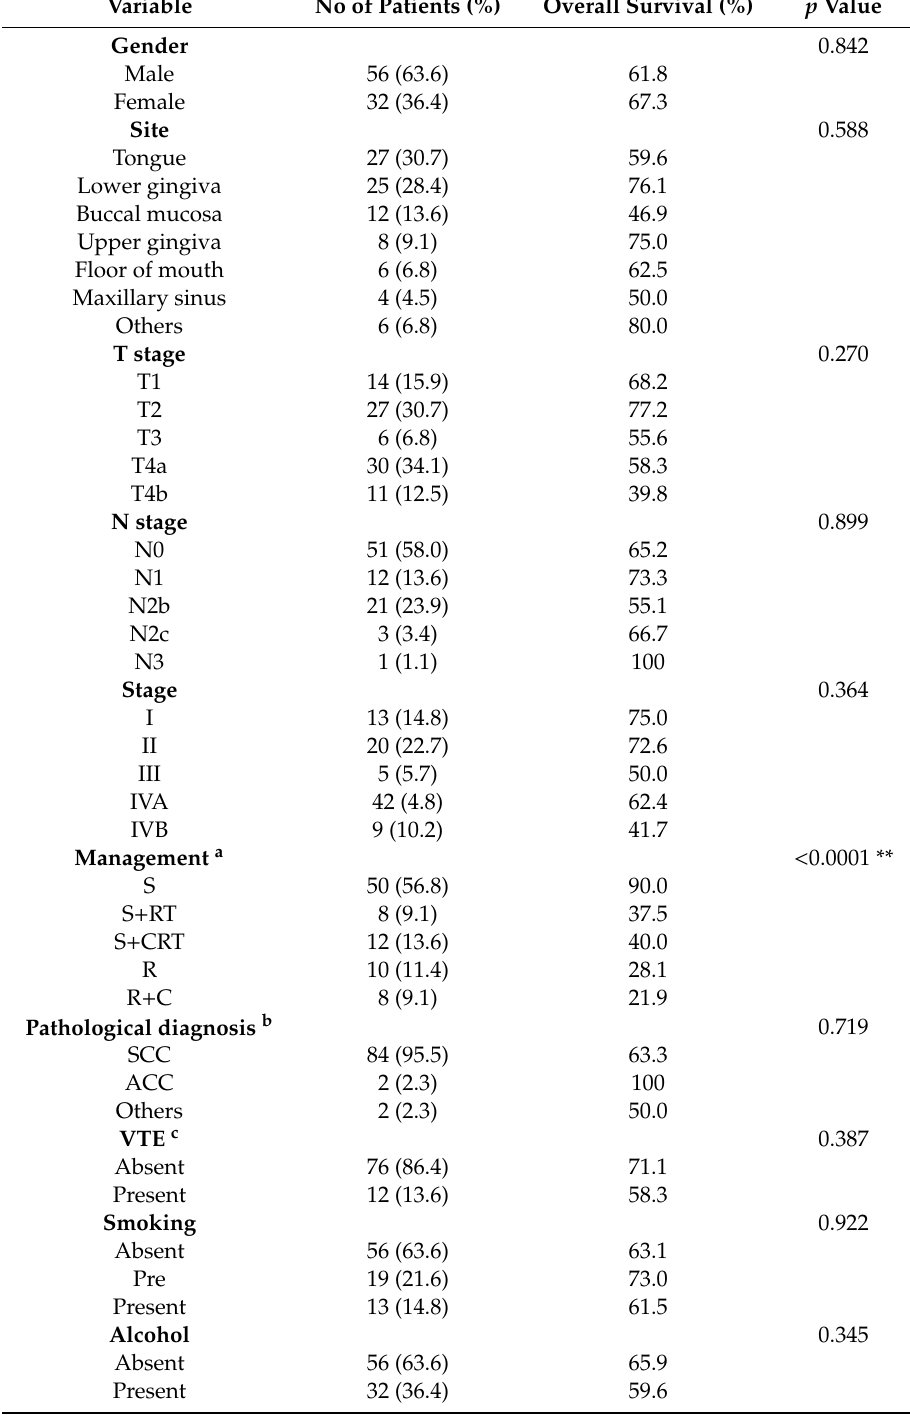
Table 3. Study variables versus overall